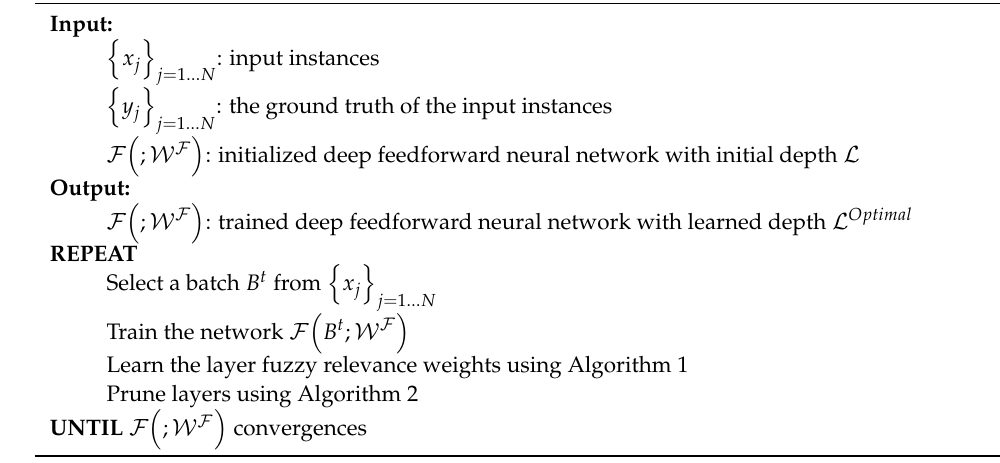
Algorithm 3: Depth-Adaptive Deep Neural Network